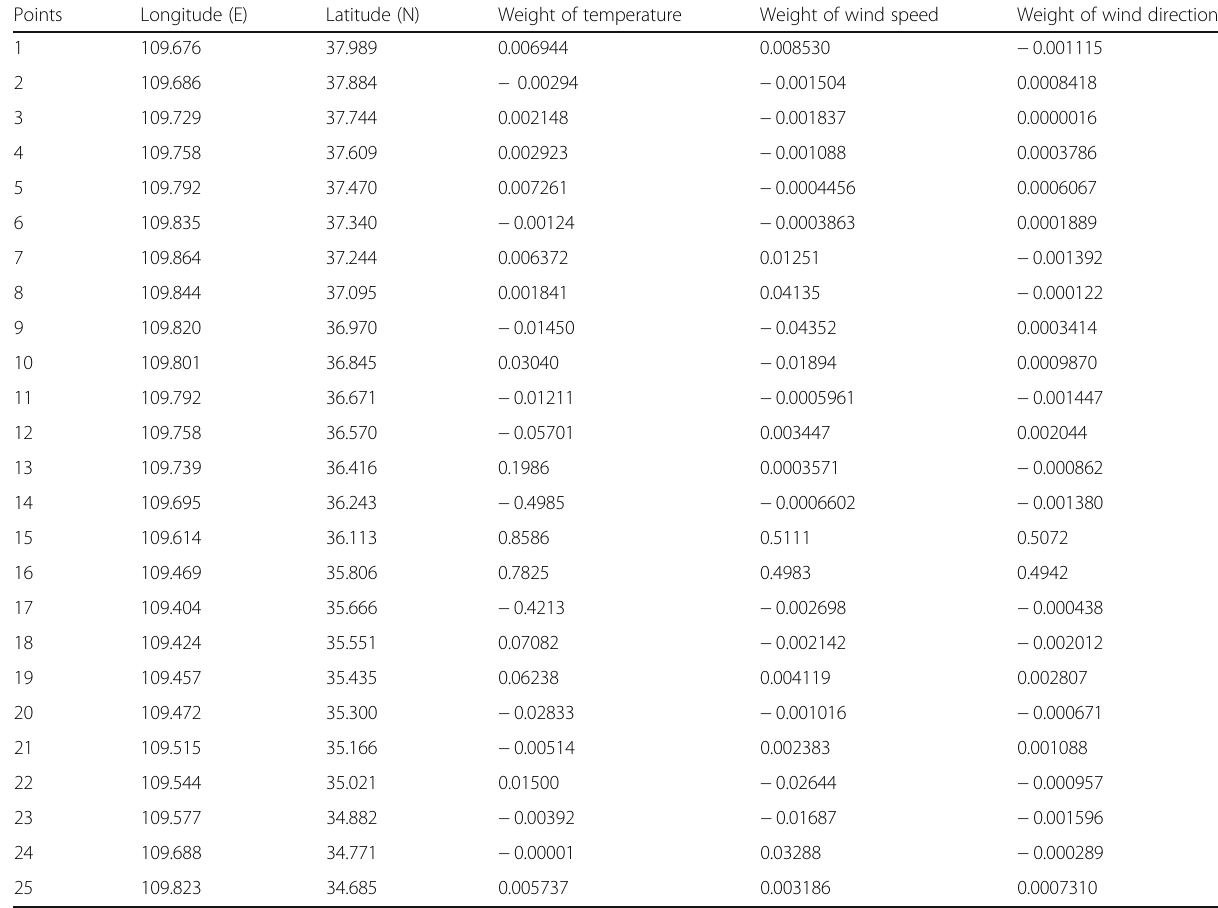
Table 4 The weight of ordinary Kriging